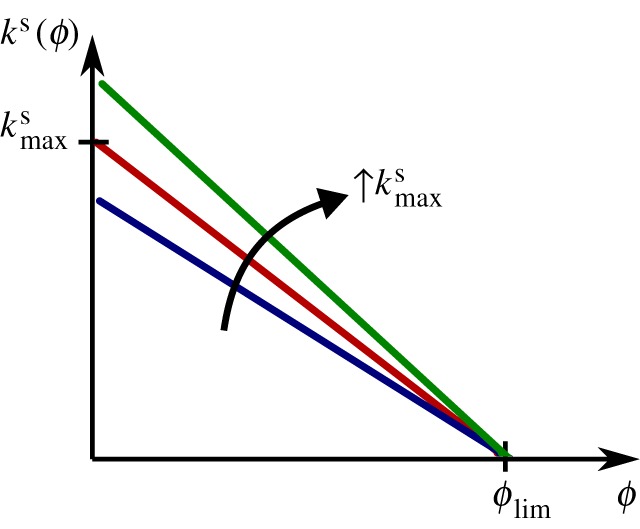
The variation of the parameter ksmax changes the slope of the function ks that regulates the stiffness increase in terms of the mechanical growth rate criterion ϕ.